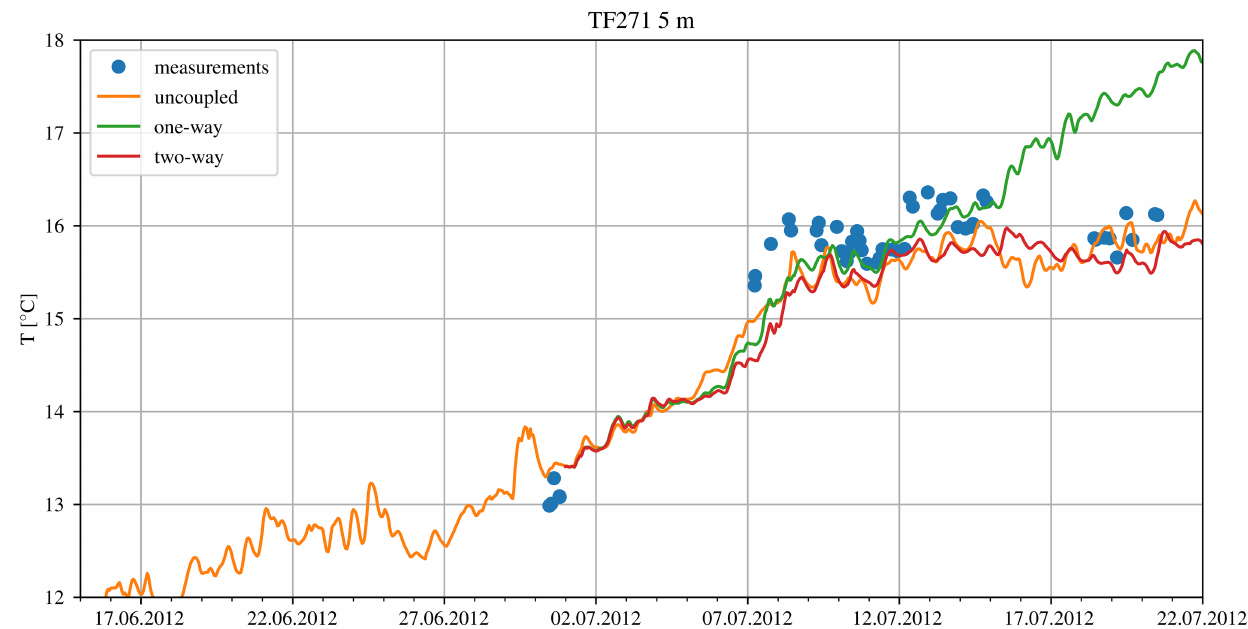
Figure 14. Temperature in 5m depth at station TF271 (see black cross in Fig. 13) from CTD measurements and the three model simulations. The one- and two-way coupled simulations are started at 1 July 2012, after the uncoupled spin-up